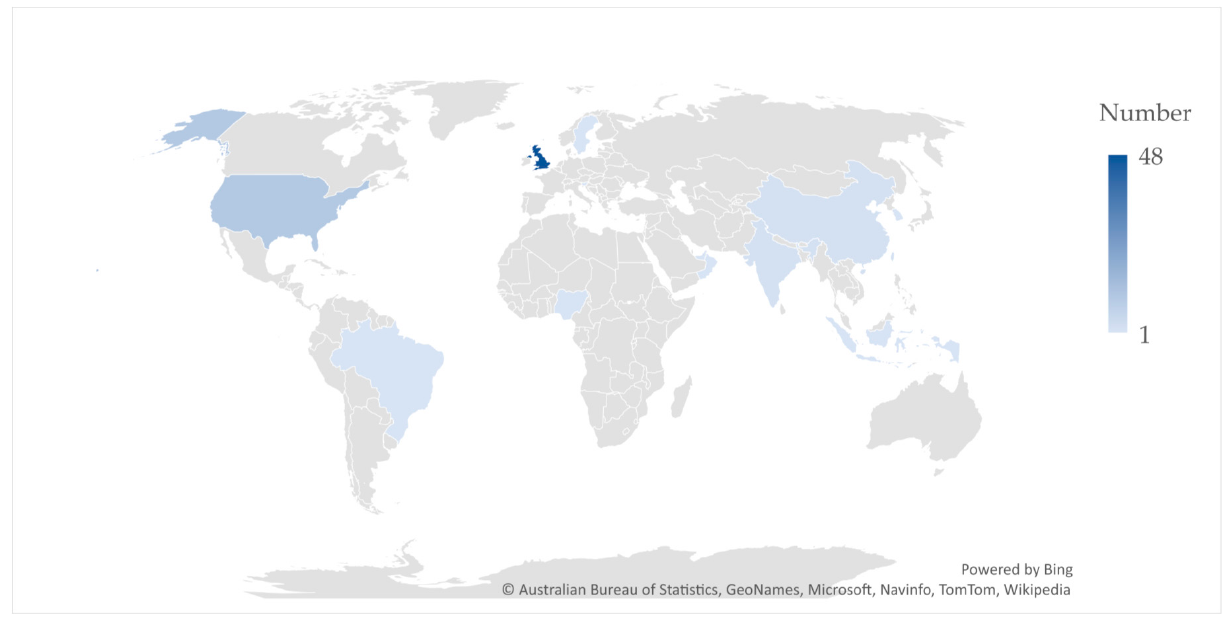
Figure 3. Co-occurrence network of countries where articles on responsible sourcing in the AEC sectors have been published (from 2000 – 2020).